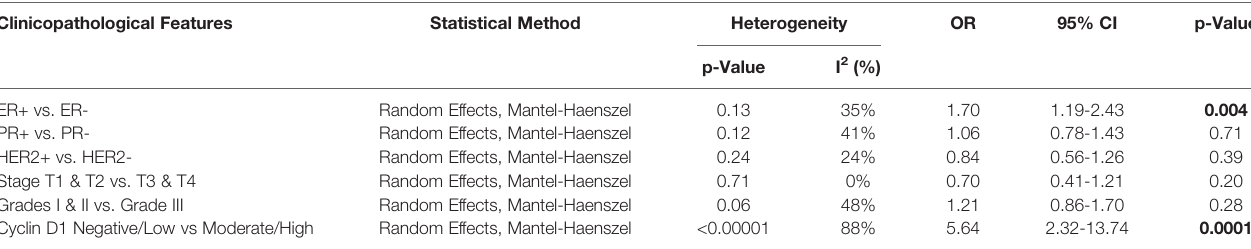
TABLE 3 | CCND1 Ampli fi cation and Clinicopathological